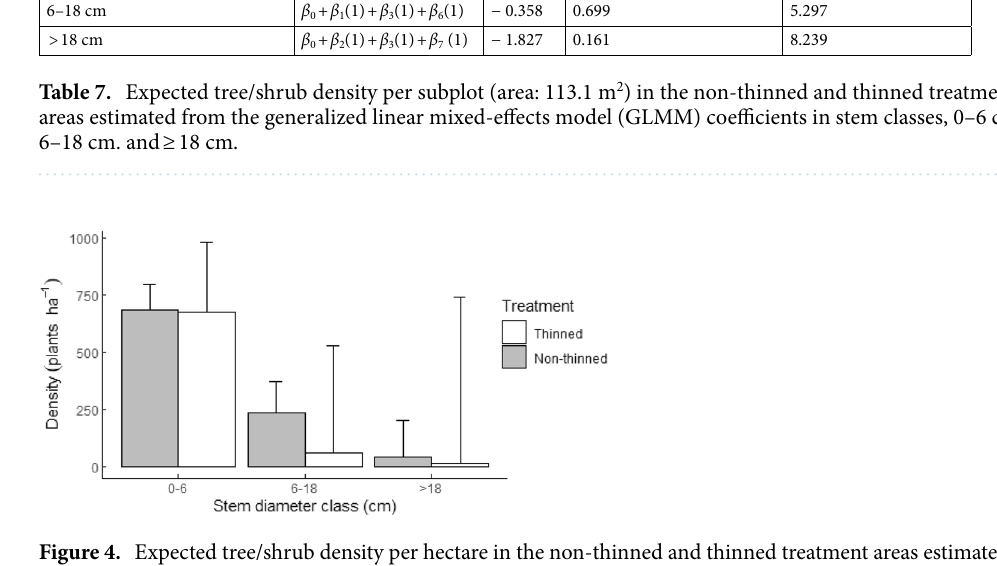
Figure 4. Expected tree/shrub density per hectare in the non-thinned and thinned treatment areas estimated from the generalized linear mixed-effects model (GLMM) model coefficients in stem classes, 0–6 cm, 6–18 cm and ≥ 18 cm. Error bars indicate ± 95% confidence level of the variability in tree/shrub densities of the three measured stem classes of the non-thinned and thinned areas.